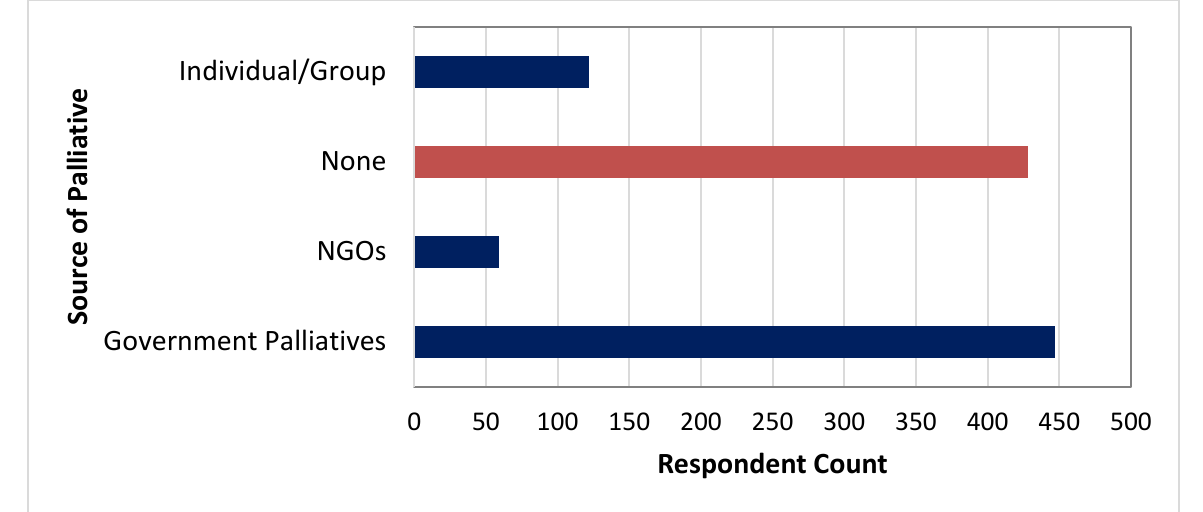
Figure 8. Palliatives distribution of the respondents.